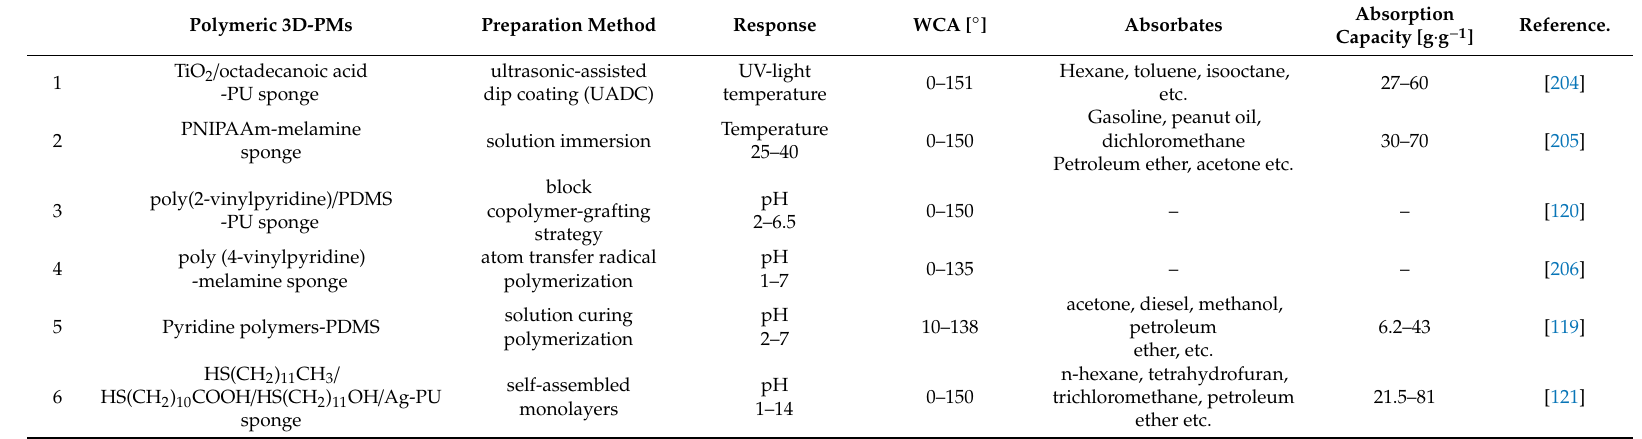
Table 3. Summary and comparison of typical examples of the polymeric three dimensional (3D) porous materials with switchable